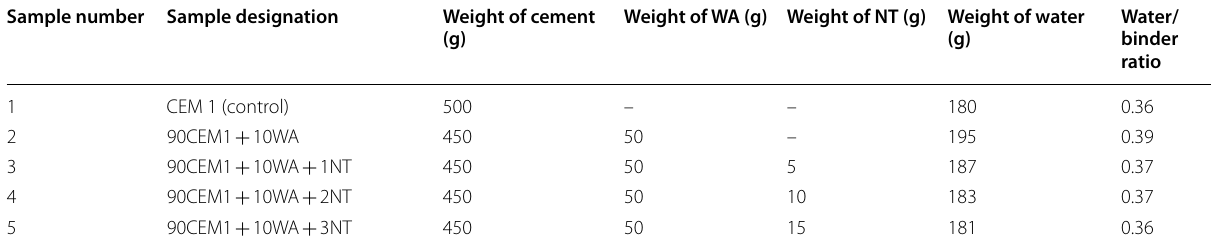
Table 3 Mix proportion of cement pastes.